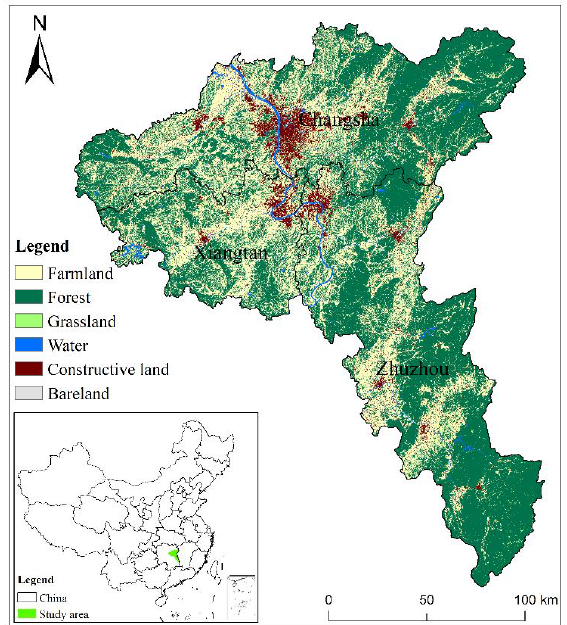
Figure 1. Geographic location of the study area.